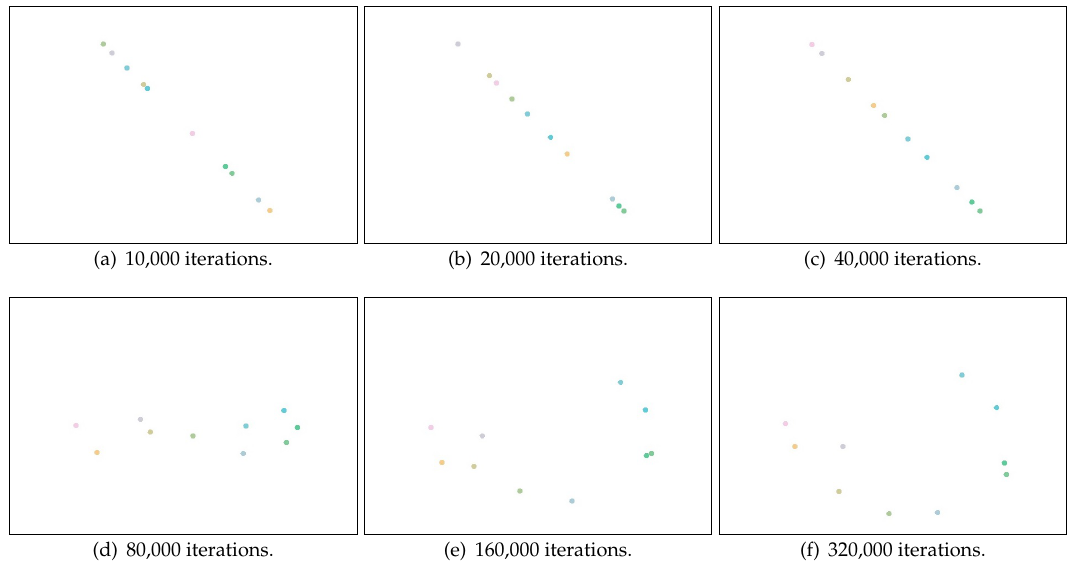
Figure 6. Learned locations after the number of